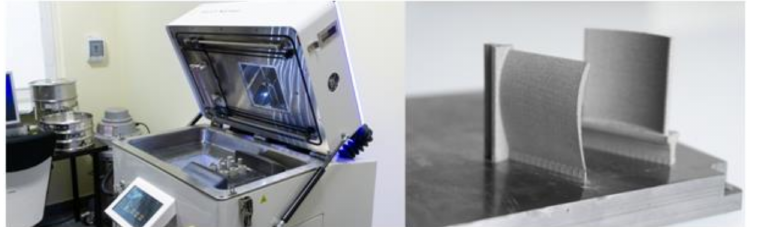
Figure 3. Possibilities for using PBF technology to manufacture critical infrastructure components—view of a device and 3D prints of power turbine blades.